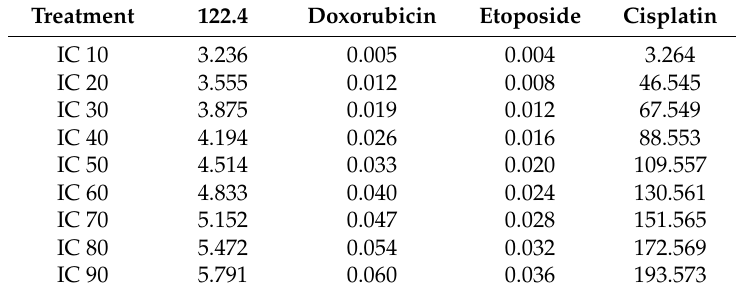
Table 1. Inhibitory concentrations (IC; IC10–IC90) of single treatments of BS-24-1 cells. IC10–IC90 of single treatment with 122.4 or doxorubicin or etoposide or cisplatin was calculated using Excel. The results presented are representative of three independent experiments. Treatment 122.4 Doxorubicin Etoposide